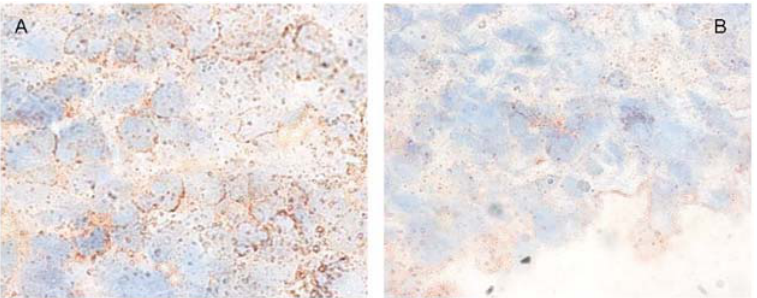
Figure 10. Nuclear morphology of immunolabeled neutrophils in the skin, close to the aspiration cavity. Panel A shows the enlarged nuclear morphology of neutrophils and intense immunolabeling using anti-mouse NIMP-R14 neutrophil antibody (in red) in a skin section of a mouse infested with a Ir-LBP siRNA-treated tick. Panel B illustrates the nuclear morphology and labeling aspect of neutrophils (in red) in a skin section of a mouse infested with a control tick (100 6 ).